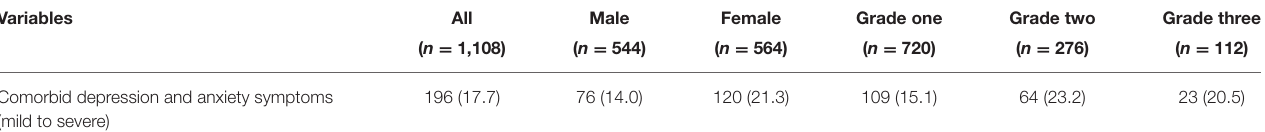
TABLE 3 | The rate of comorbid depression and anxiety symptoms in high school students.